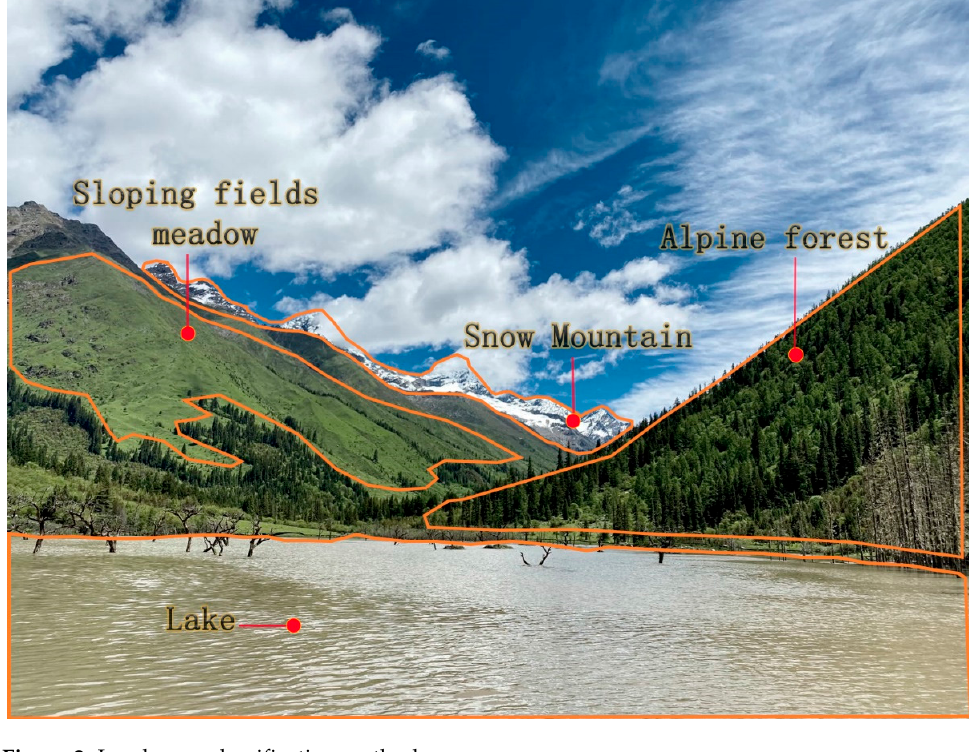
Figure 2. Landscape classification methods.